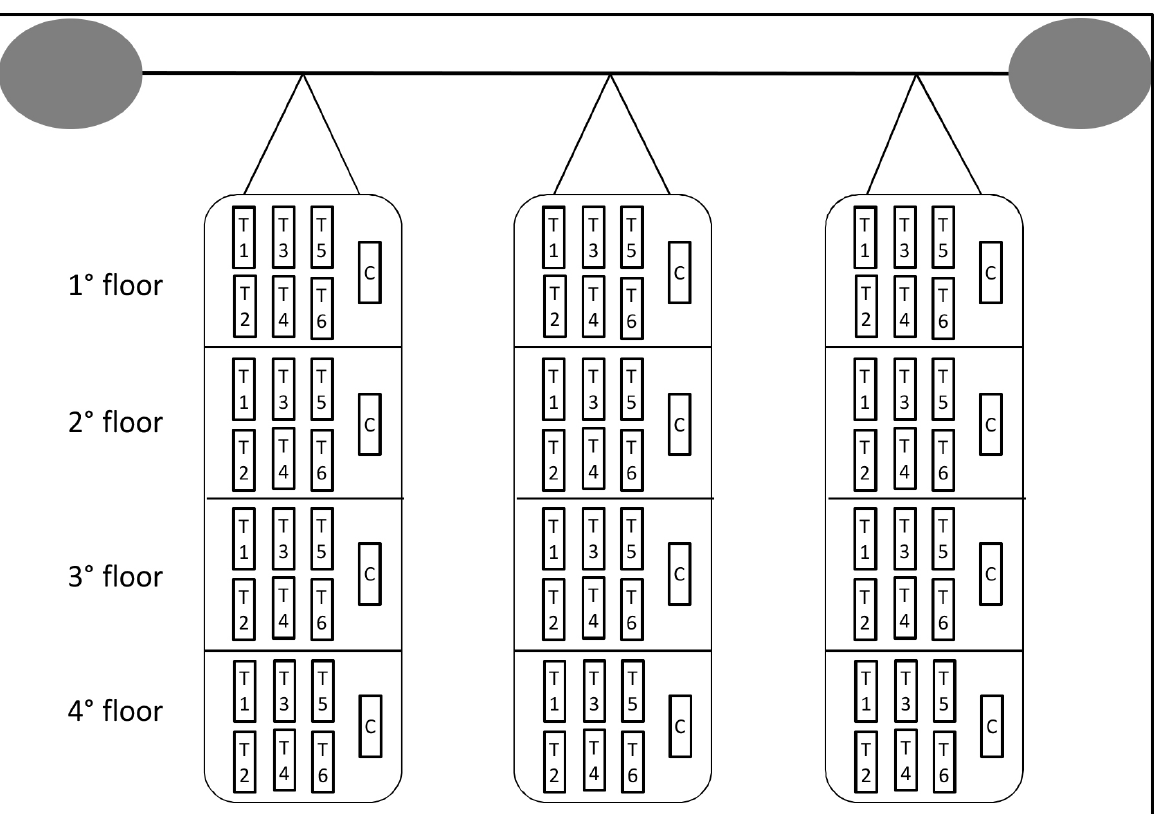
Figure 1. General layout of treatments in the Japanese lanterns during the experiment. T = Treatment; C =